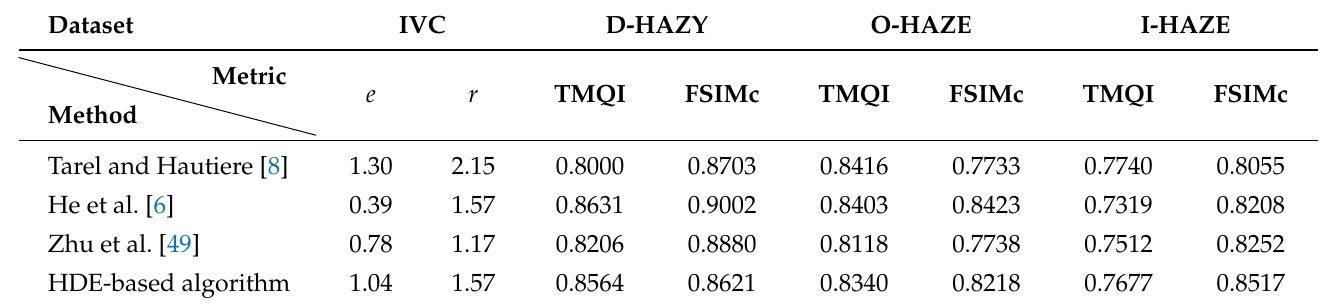
Table 7. The quantitative evaluation results of different dehazing methods on the IVC, D-HAZY, O-HAZE, and I-HAZE datasets.